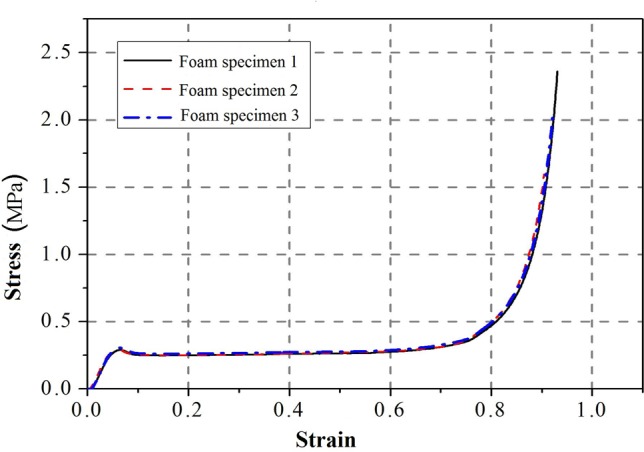
Stress-strain curves from flat crush tests of the foam core material.